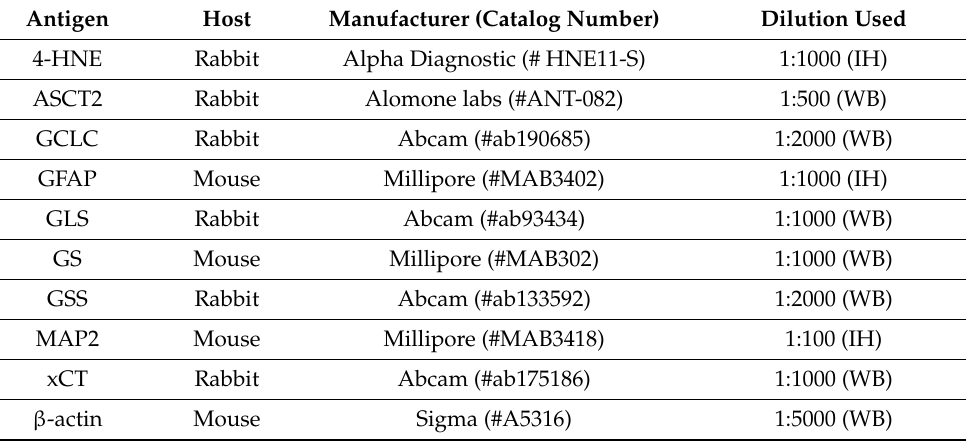
Table 1. Primary antibodies used in the present